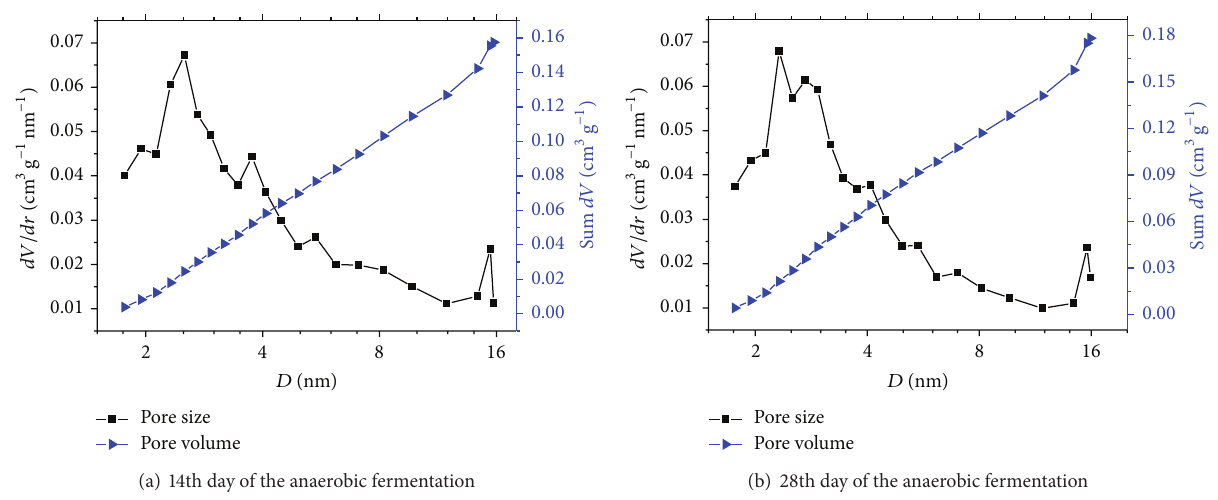
Figure 8: The distribution curve of pore volume and pore size of sample